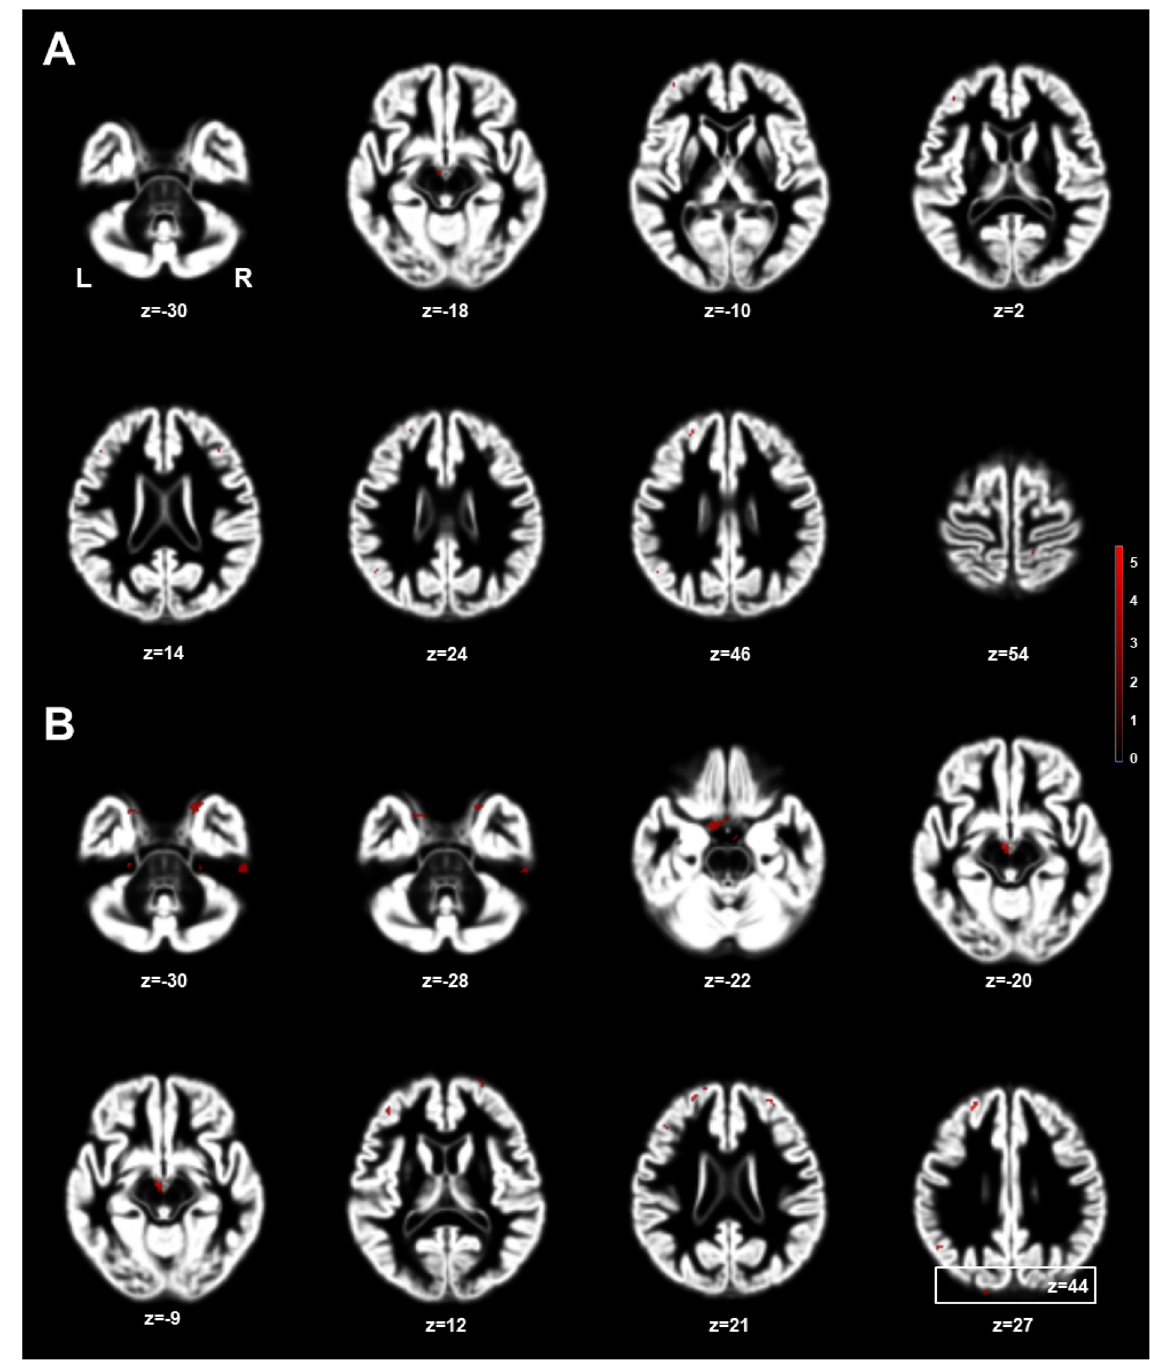
Figure 1. Brain areas with larger gray matter volumes in menopausal hormone therapy (MHT) women relative to noMHT women, which analyzed with independent two-sample t -test ( A ) and analysis of covariance (ANCOVA) ( B ) adjusting for age and total intracranial volume (TIV) (corrected p < 0.05; threshold t = 3.0, cluster size 50). The red color-coded pixels were scaled to the range ( t -value 3.00–5.50) more than the cut-off threshold. L = left; R =